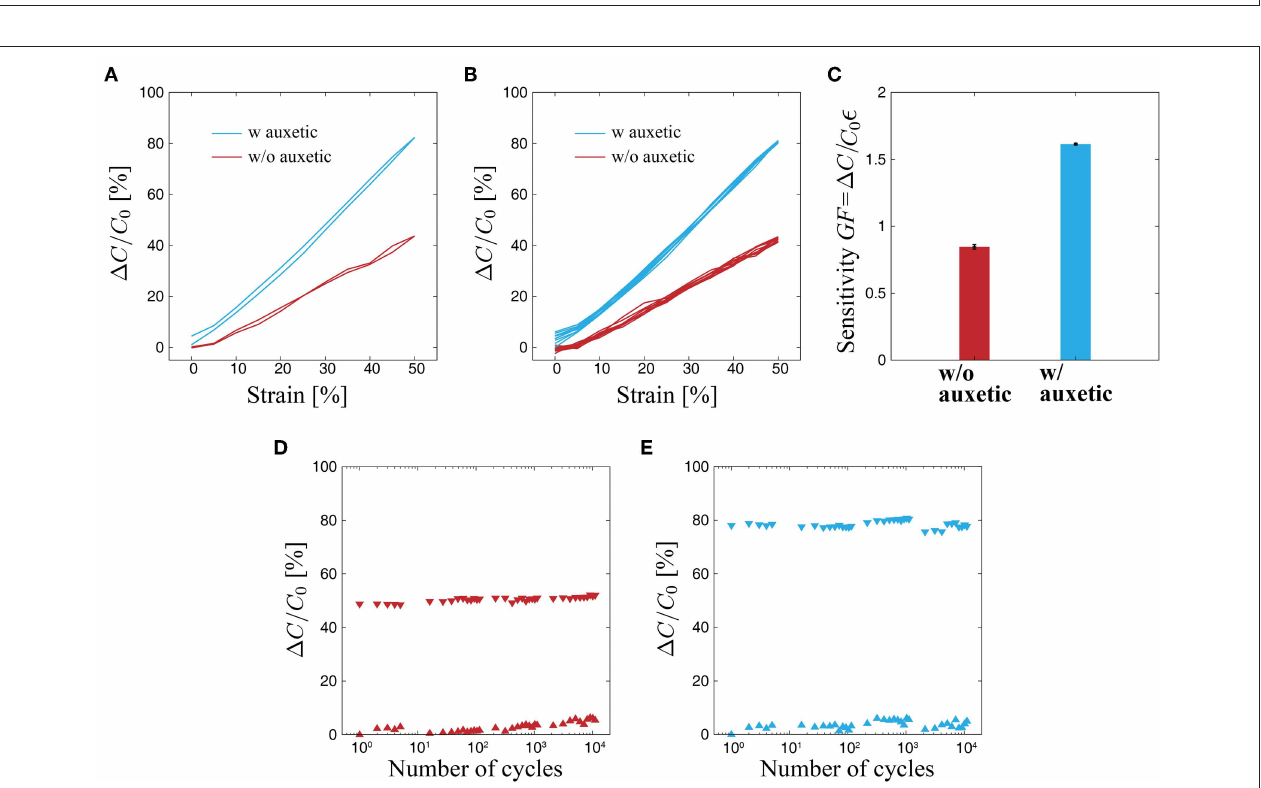
FIGURE 3 | Deformation of the fabricated sensors at the applied strain of 0, 25, and 50% (top view). (A) Sensor without the auxetic structure and (B) sensor with the auxetic structure.